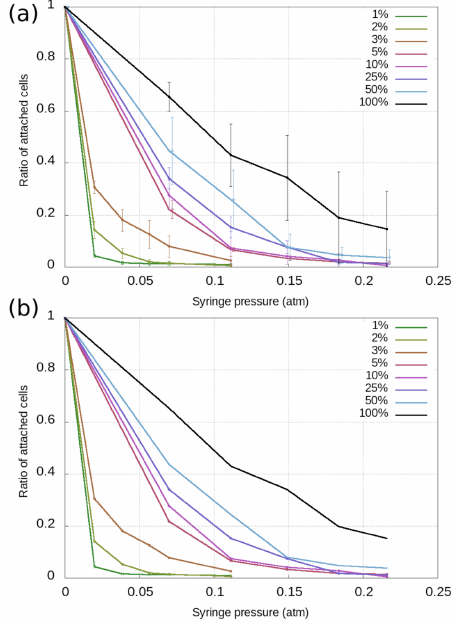
Figure 2. Curves representing the detachment of cells from surfaces with different PPR to PP ratios ( Q ). ( a ) Averaging of data: each point corresponds to the average of values measured in three separate experiments, while the error bars represent the standard error. ( b ) The pooling of data: points correspond to unified datasets coming from three separate